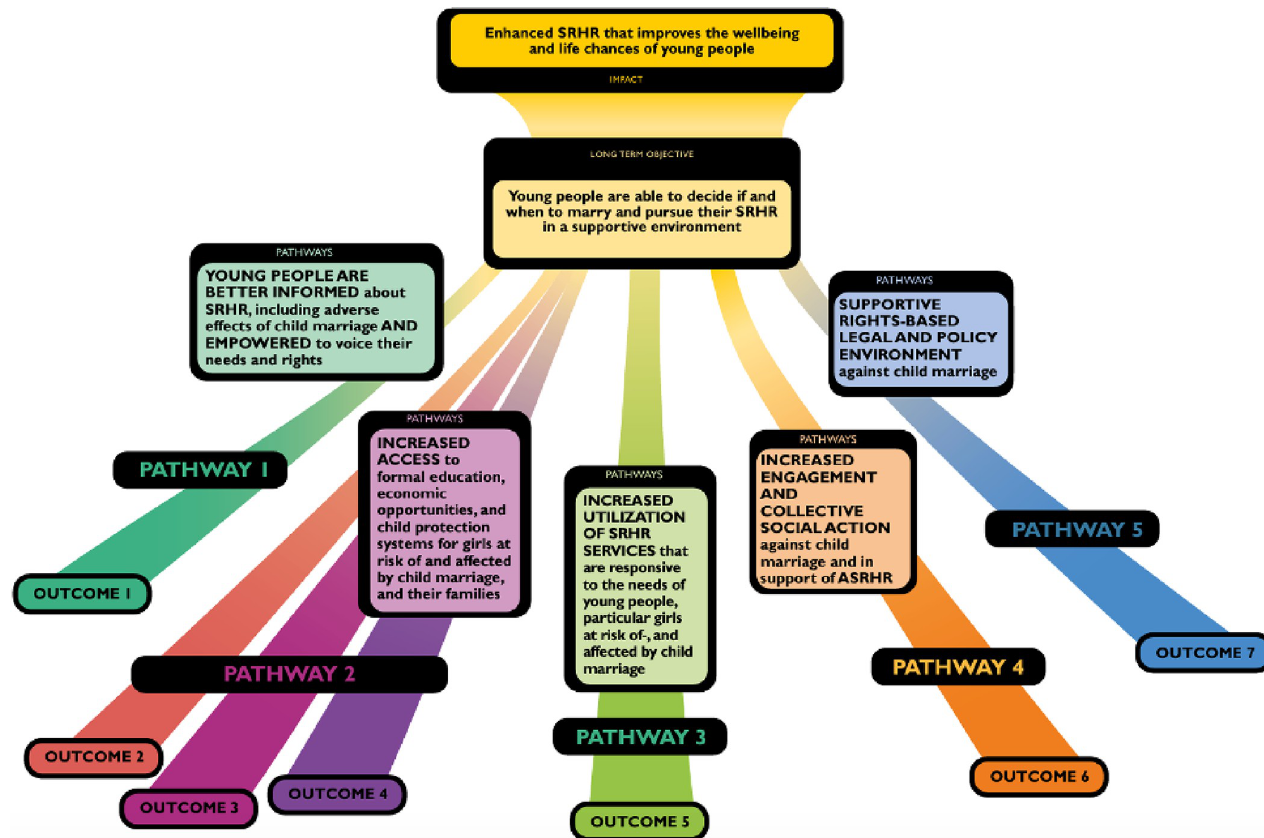
Fig 2. More Than Brides Alliance Theory of